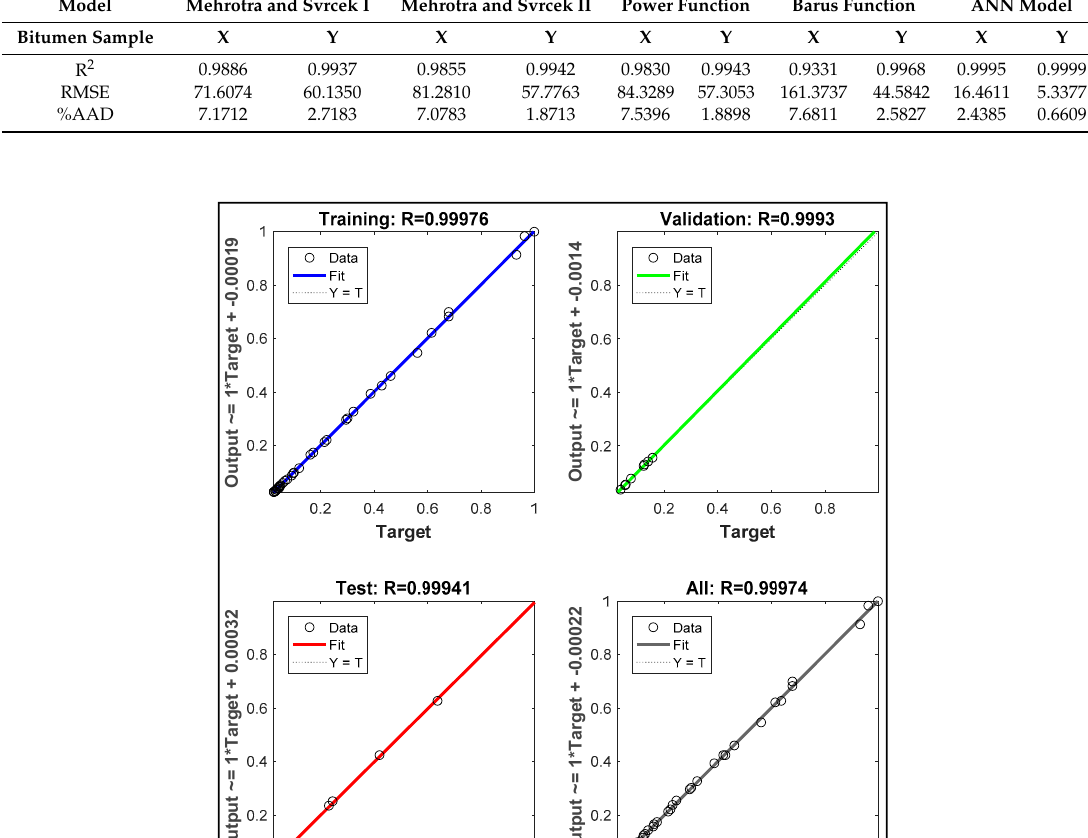
Figure 11. Artificial neural network (ANN) regression plots for sample Y.